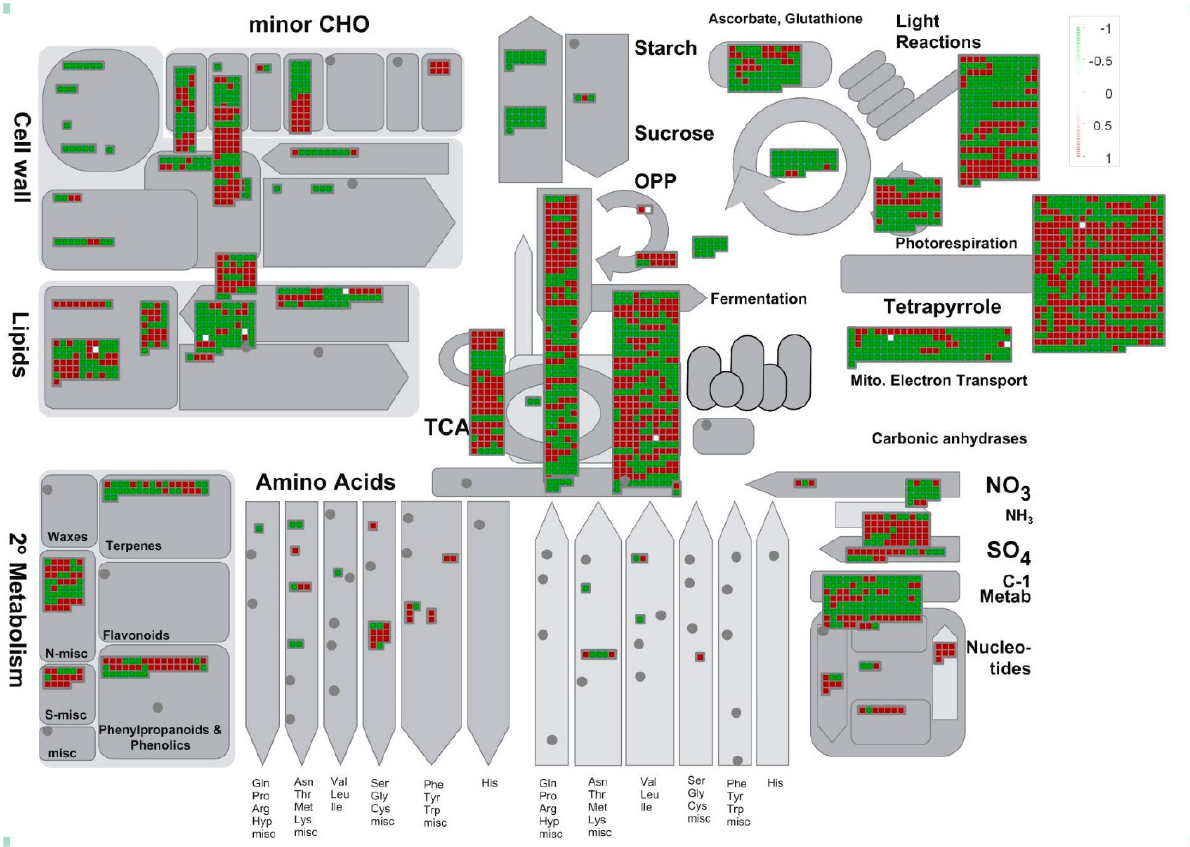
Figure 10. Comprehensive view of DEGs involved in multiple metabolic pathways analyzed by MapMan.